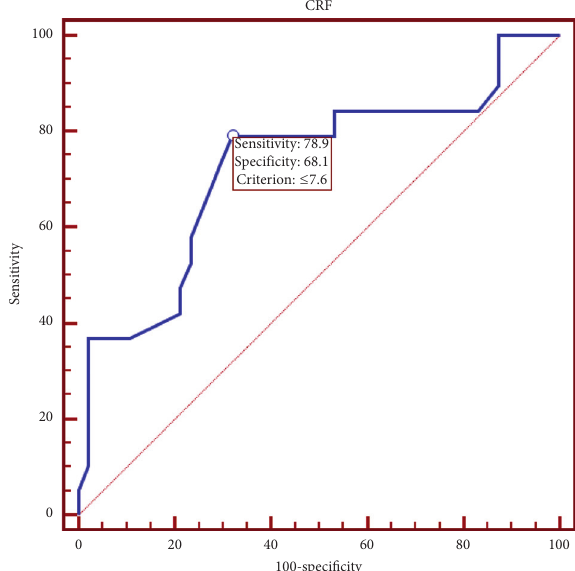
Figure 9: Corneal resistance factor receiver operating characteristic curve